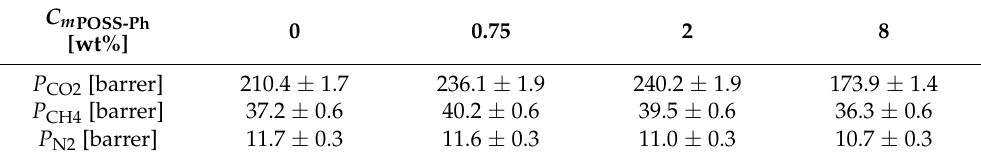
Table 8. Permeation coefficients P i of the test gases for membranes of different POSS-Ph concentrations.